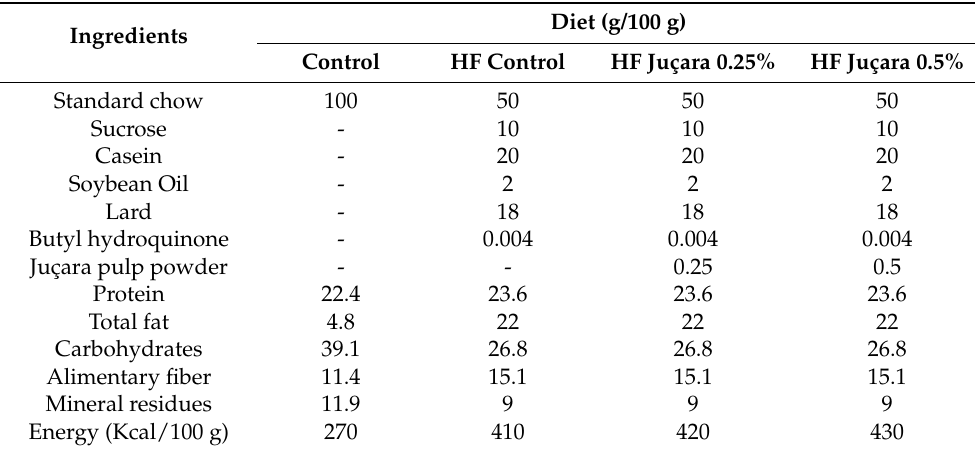
Table 4. Ingredients and nutritional composition of experimental diets proposed by Dornellas [18] supplemented or not with juçara